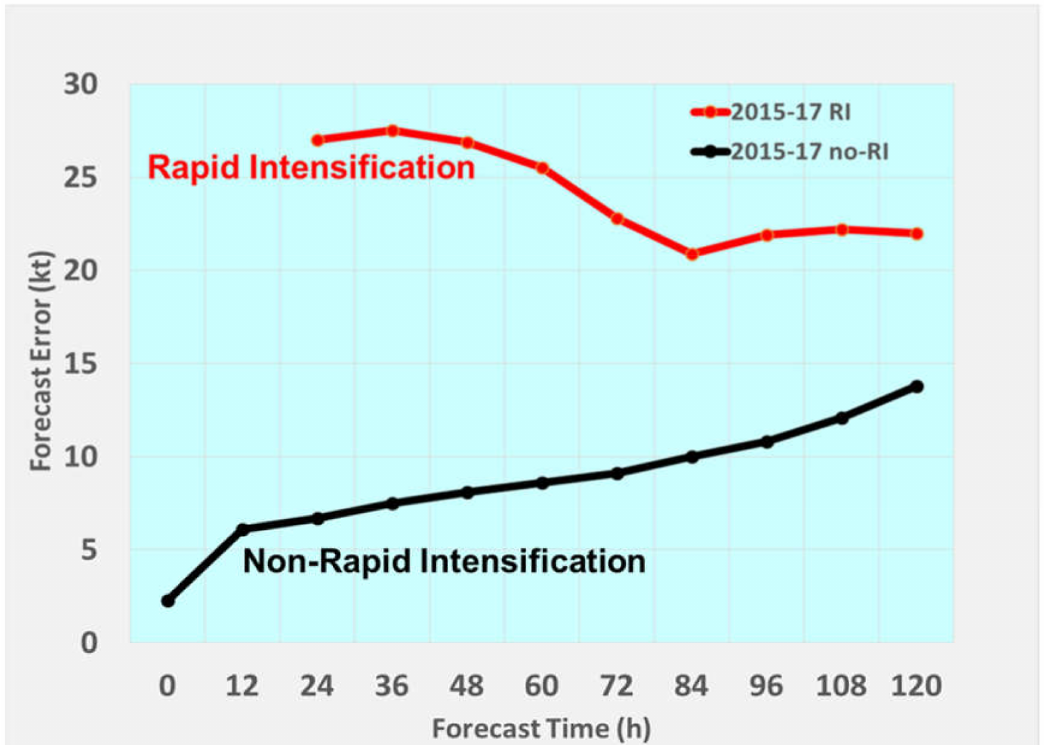
Figure 1. Intensity forecast errors (kt) from consensus of two statistical/dynamical models (Decav-SHIPS, Logistical Growth Equation Model) and two regional deterministic models (intelpolated HWRE, COAMPS-TC) for TCs between 2015 and 2017. Black line shows intensity forecast errors for all TCs not undergoing RI; red line shows errors for all TC’s undergoing